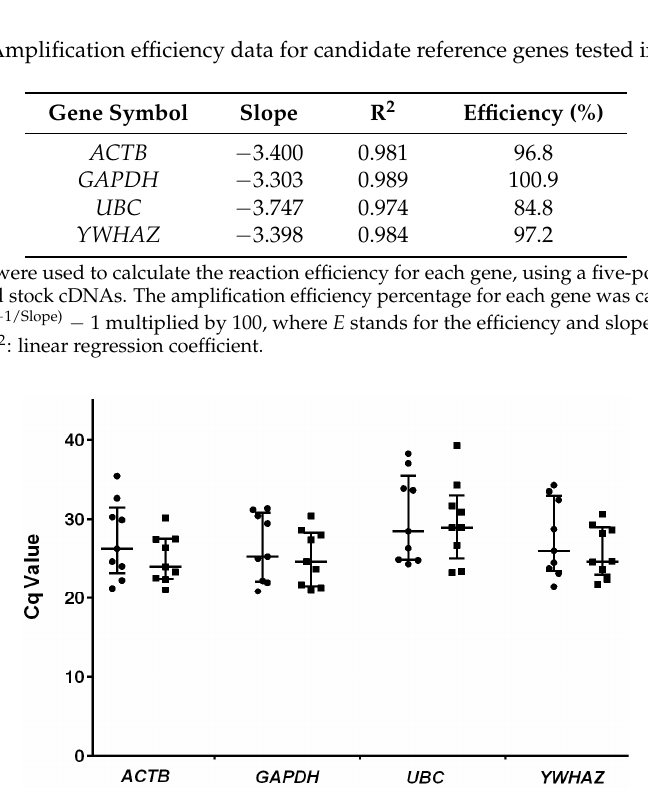
Figure 2. Scatter plot representations of the Cq values measured for the final four candidate genes. Filled squares and circles represent the control and autistic groups, respectively. The vertical bars indicate the median and interquartile range. The bottom and top of each bar represent the 25th and 75th percentiles, respectively, and the line bisecting each bar shows the median Cq value.